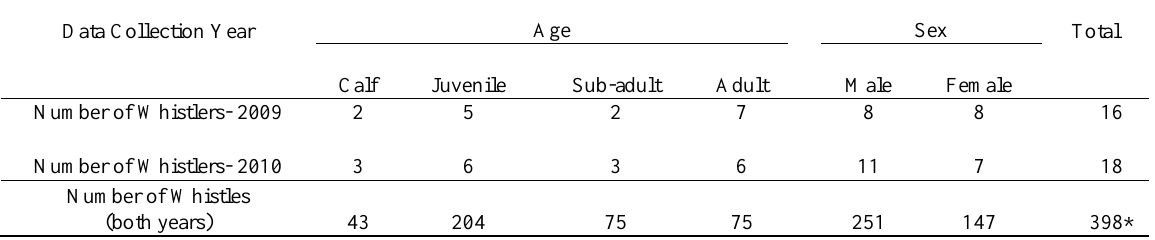
Number of Whistling Dolphins and Whistles Recorded According to Categories of Age Class and Sex